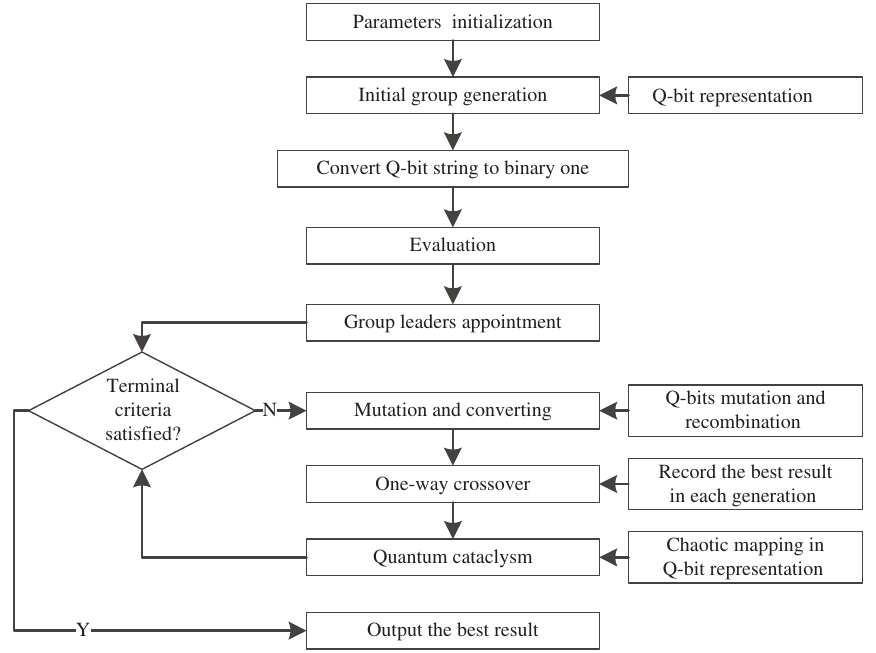
Figure 2: Integrated Framework of